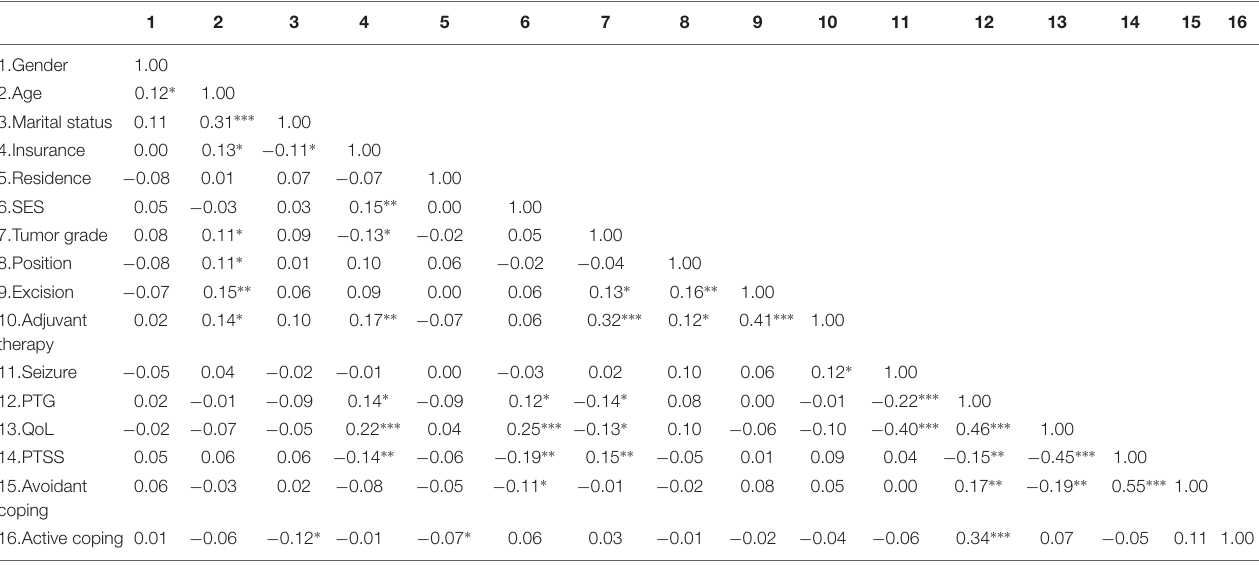
TABLE 2 | Correlations of study variables.